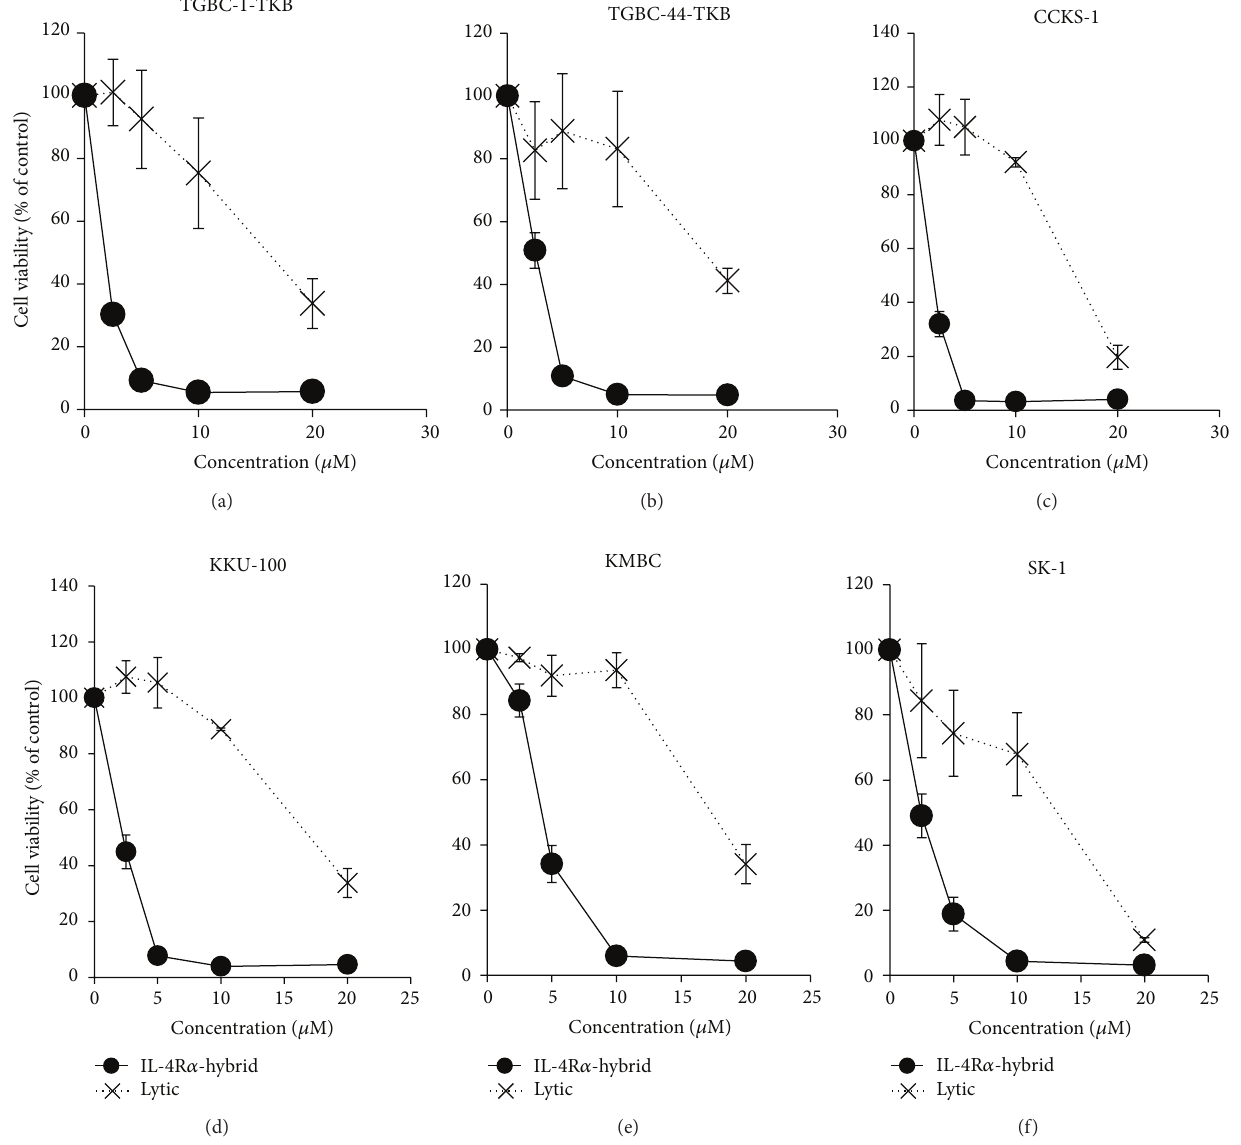
Figure 2: Cytotoxic activity of IL-4R 𝛼 -lytic hybrid peptide. Six BTC cell lines were cultured with various concentrations of IL-4R 𝛼 -lytic hybrid peptide or lytic peptide (0–20 𝜇 M) for 72 h, and cytotoxic activity was assessed using WST-8 reagent. The results are represented as mean ± SD (bars) of triplicate determinations, and the assay was repeated three